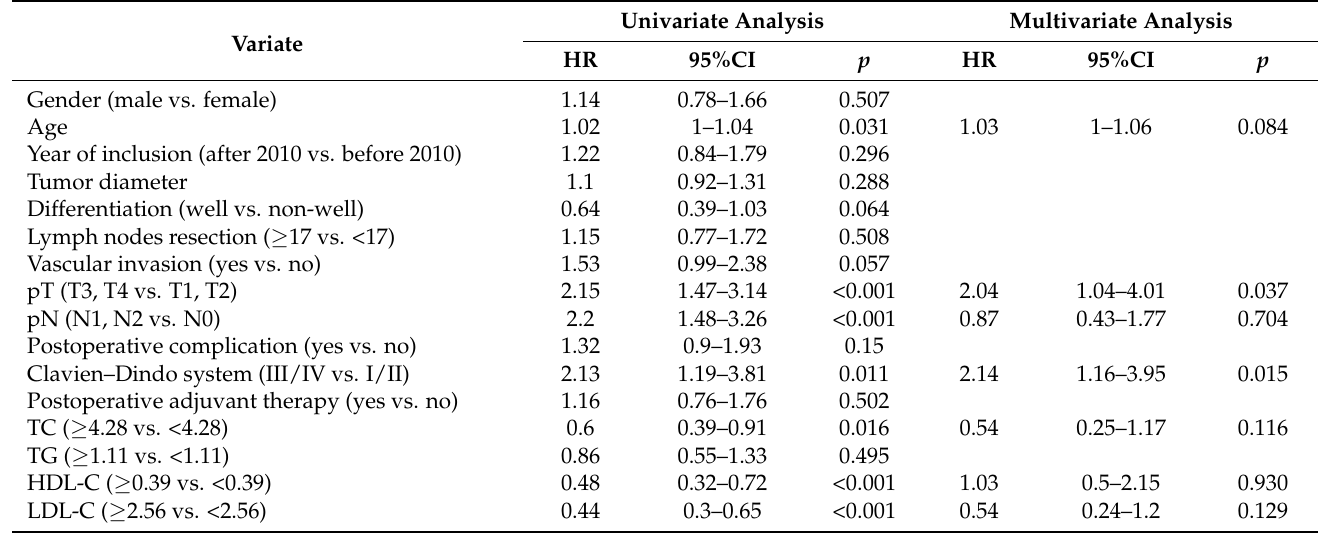
Table 6. Univariate and multivariate analysis of ampullary adenocarcinoma with OS. Univariate Analysis Multivariate Analysis Variate HR